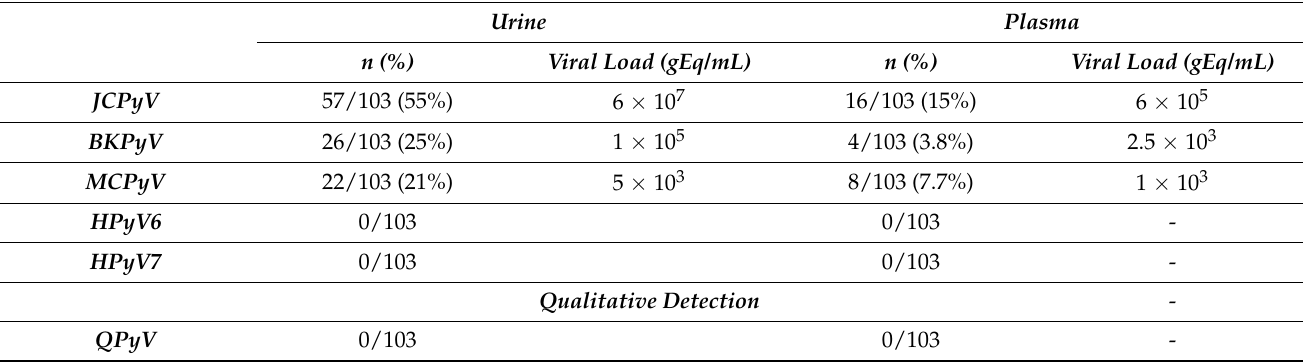
Table 4. HPyVs prevalence and mean viral load in urine and plasma of HIV-1-infected patients. Urine Plasma n (%) Viral Load (gEq/mL)